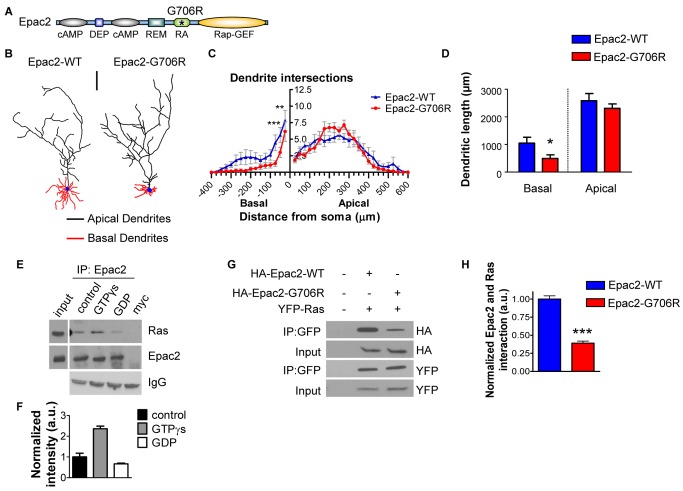
Disruption of Epac2 interaction with Ras by point mutation impairs basal dendritic maintenance.(A) Domain structure of Epac2: cAMP-binding (cAMP); domain found in Dishevelled, Egl-10, and Pleckstrin (DEP); N-terminus of Ras-exchanger motif (REM); Ras-association (RA); Rap-Guanine Exchange Factor (Rap-GEF). Asterisk indicates position of Epac2-G706R rare variant. (B) Representative binary images of cortical neurons expressing GFP+Epac2-WT or GFP+Epac2-G706R. (C) Sholl analysis of apical and basal dendrites reveals a significant decrease in basal complexity in Epac2-G706R-expressing cells. (D) Quantification of apical and basal dendrite length. (E) Ras activation by GTPγs results in stronger coimmunoprecipitation of Epac2 with Ras in neurons, while inactivation of Ras by GDP reduces Ras-Epac2 interaction. (F) Quantification of (E). (G) Epac2-G706R point mutation exhibits impaired interaction with Ras in hEK293 cells. (H) Quantification of G. *p<0.05, **p<0.01, ***p<0.001; scale bar, 100 µm.